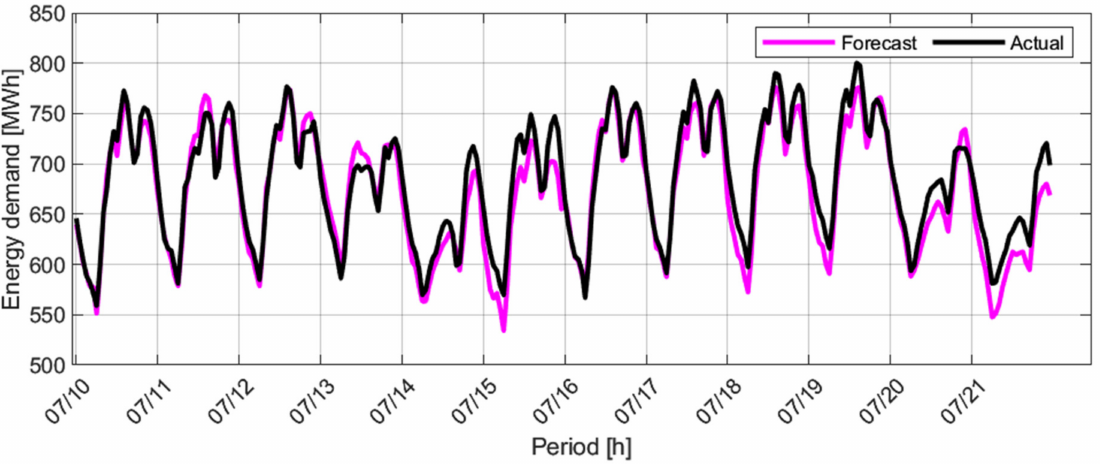
Figure 7. Forecast and actual data for the energy demand of the Atl á ntico electricity market.